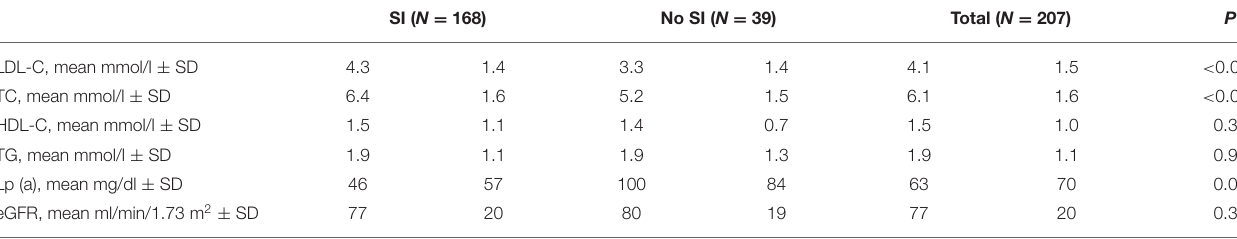
TABLE 2 | Baseline laboratory parameters according to the presence of statin intolerance. SI ( N = 168) No SI ( N = 39) Total ( N = 207) P